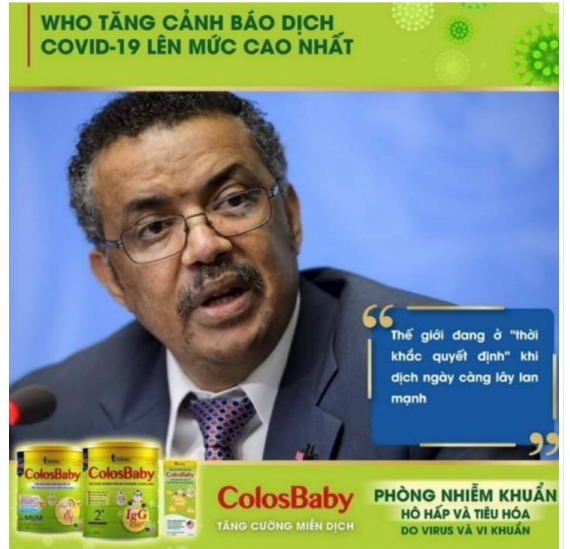
Figure 1. A screenshot from Facebook of Colosbaby advertisement in Vietnam that featured the World Health Organization’s (WHO) Director-General headshot with a caption at the top, “WHO raises COVID-19 threat warning to its highest level”. “The world is entering a decisive moment when coronavirus disease is spreading more rapidly” appeared like a quote from him. Next to the products were captions “ColosBaby Boost immune system” and “Prevent respiratory and digestive infections caused by viruses and bacteria” (translated from